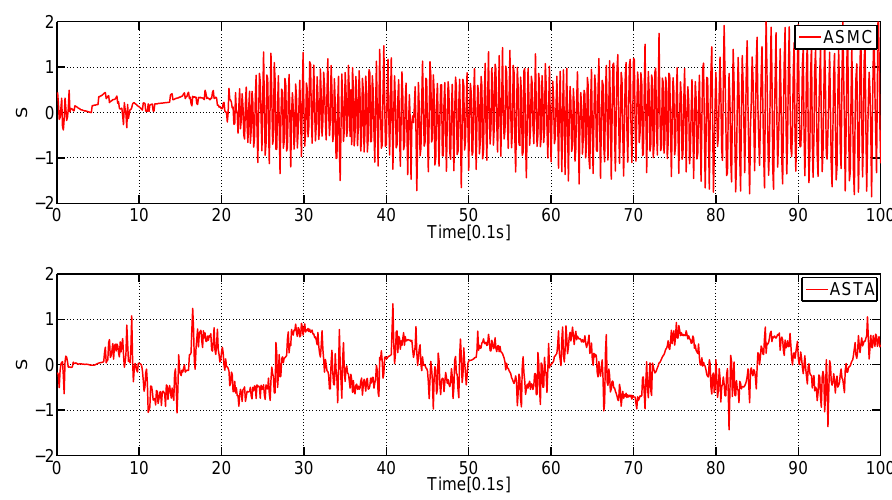
Figure 9. Comparison of the sliding mode variables in Case 2.